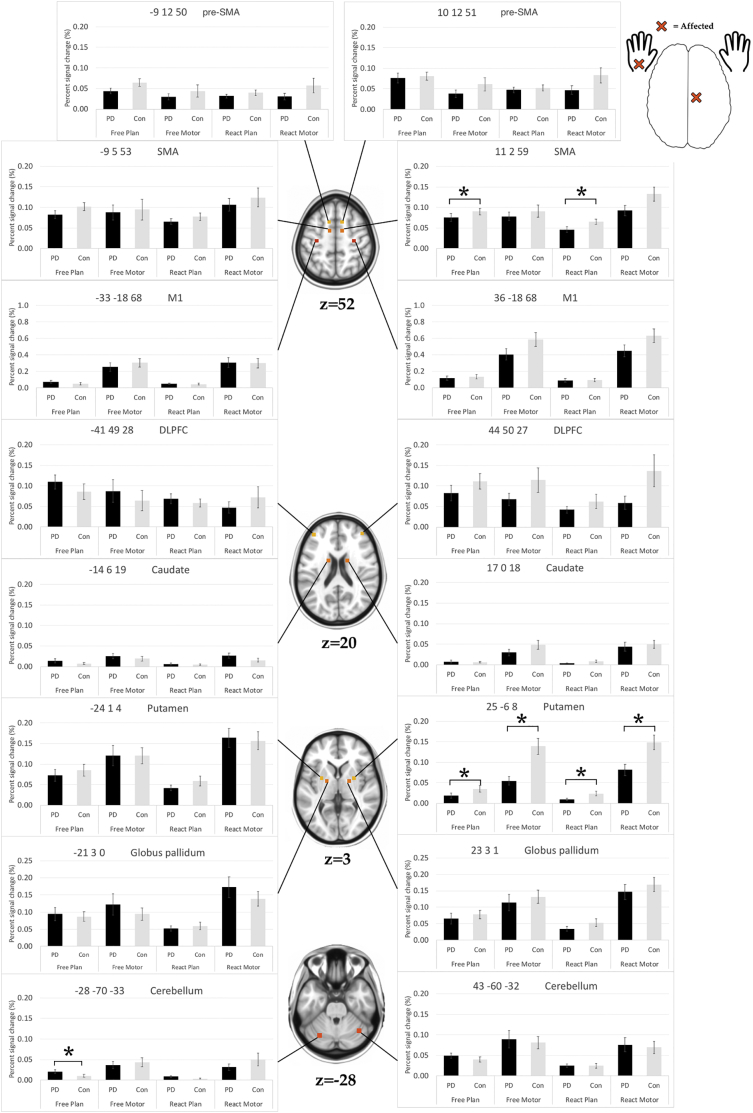
ROI analysis.Illustration of the location of the sixteen regions from the region of interest (ROI) analysis (bilateral – M1, SMA, pre-SMA, DLPFC, caudate, putamen, globus pallidum, and cerebellum) on a template. Data shown are group percentage-signal-change (mean ± SEM) for the affected hand: for each ROI, we extracted the beta estimate and calculated the percentage-signal-change for each participant and the average calculated for each condition event and averaged across participant group. The significance of the group differences was estimated using non-parametric Mann-Whitney U test for each condition separately (i.e. FREEPLAN, FREEMOTOR, REACTPLAN, REACTMOTOR). The asterisks indicate that the difference is significant (p < .05).